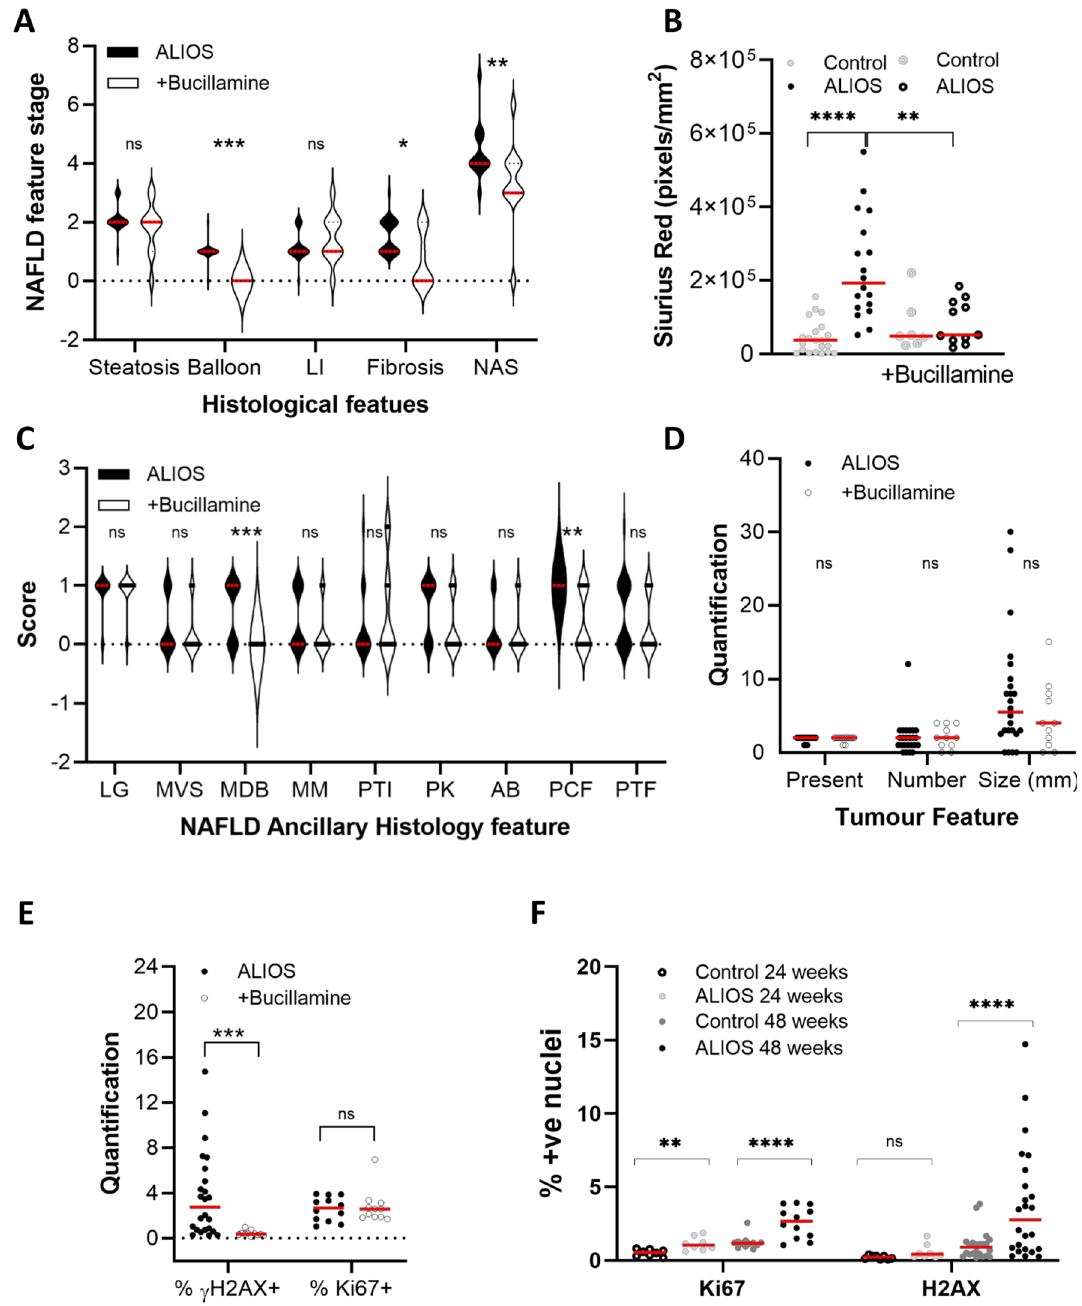
Figure 5. The impact of bucillamine on NASH, DNA damage, cellular proliferation and HCC. Dietary supplementation with bucillamine in ALIOS fed C3H/He mice had no impact on steatosis or lobular inflammation, although a cardinal feature of NASH—hepatocyte ballooning—was abrogated, with a corresponding reduction in the NAS score, alongside a significant reduction in fibrosis stage ( A ) and Sirius Red quantification ( B ). Of the ancillary features of NASH, Mallory-Denk bodies (MDB) were reduced, as was pericellular fibrosis (PCF), with no changes in the presence of lipogranulomas (LG), microvesicular steatosis (MVS), megamitochondria (MM), portal tract inflammation (PTI), pigmented Kupffer (PK) cells, apoptotic bodies (AB) or portal tract fibrosis (PTF) ( C ). Despite reduced severity of NASH and fibrosis, there was no impact tumour development or size ( C ). DNA damage H2AX foci were diminished, although the hepatocyte proliferation biomarker Ki67 was not ( E ). Quantification at 24 weeks of age confirmed a significant increase in Ki67 assessed proliferation in ALIOS fed mice, further increased at 48 weeks. Induction of H2AX was more dramatic in ALIOS fed mice, but only at 48 weeks. Categorical data statistical differences determined by Chi Square tests; scale data by Mann Whitney Tests (ns-not significant, * p < 0.05, ** p < 0.01, *** p <